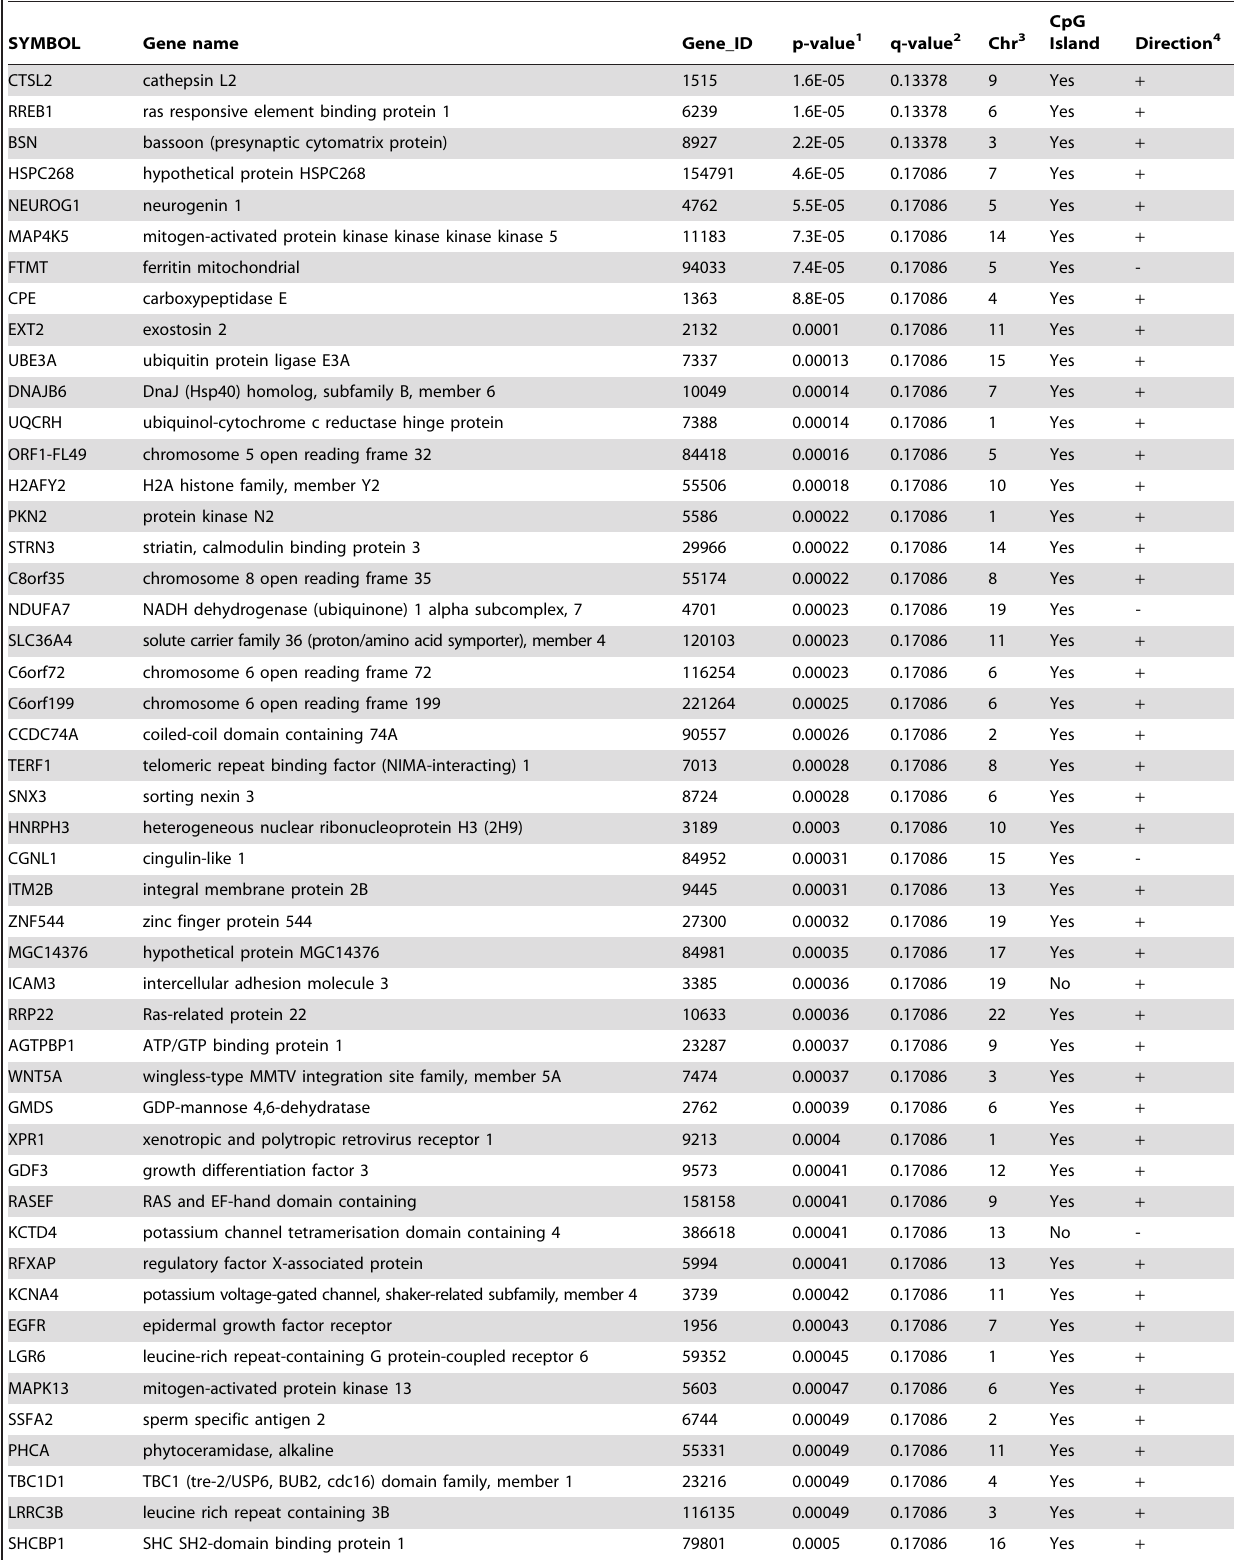
Table 2. Top 50 differentially methylated genes ranked by statistical significance.